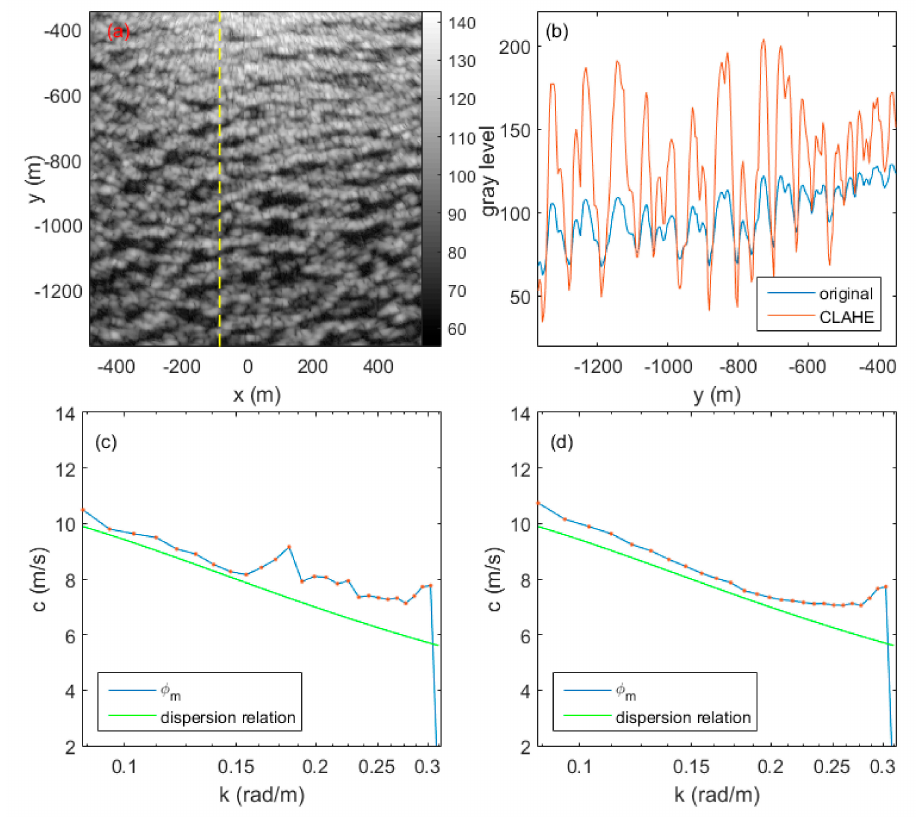
Figure 6. ( a ) Part of the X-band marine radar image acquired at 12:00 a.m. on 29 October 2014. ( b ) The gray levels of the yellow dashed line in (a) with and without preprocessing. The phase velocities derived from radar images ( c ) without and ( d ) with contrast limited adaptive histogram equalization